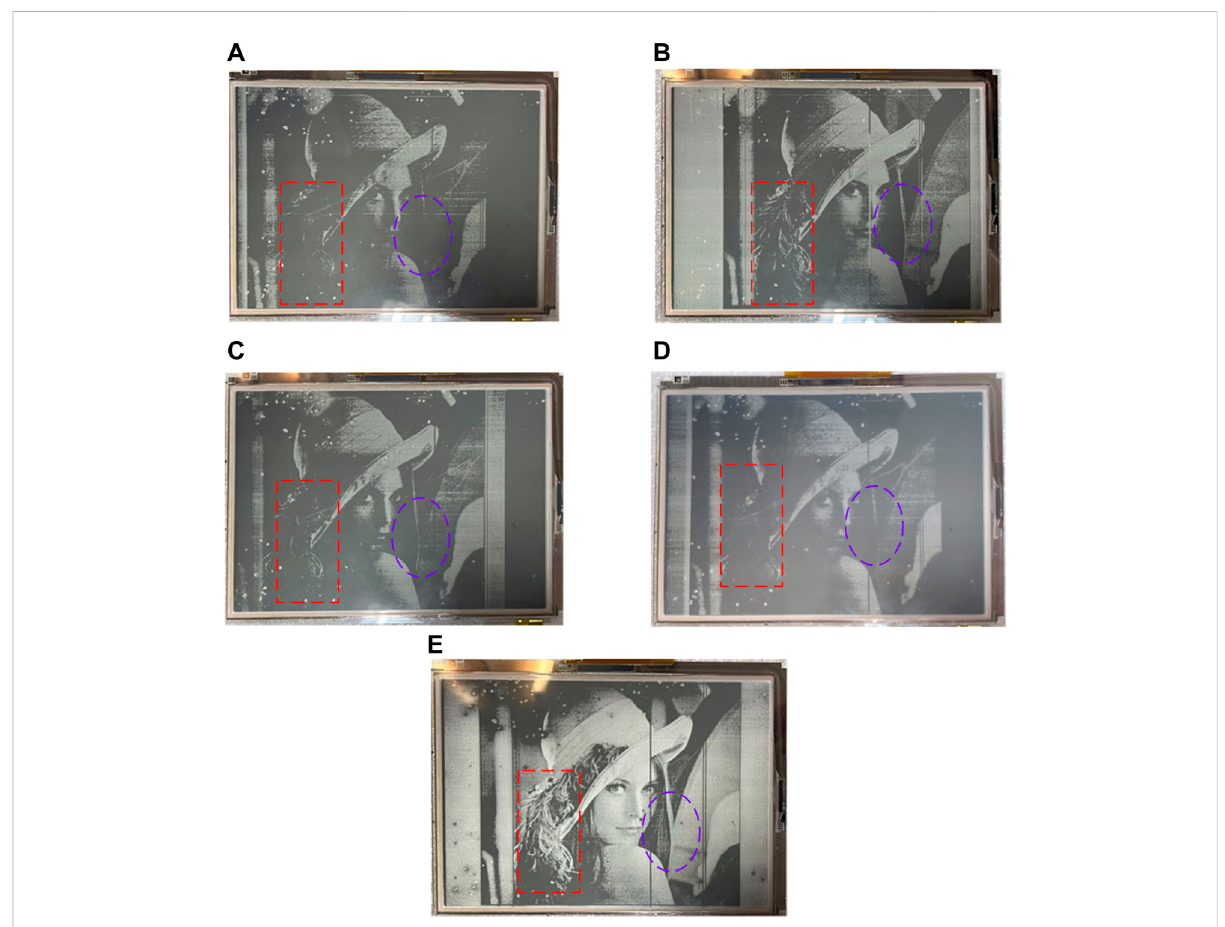
FIGURE 11 The picture of ‘ Lena ’ displayed on the EWD. (A) Displayed with the AC driving composed of +15 V and -15 V. (B) Displayed with the AC driving composed of +20 V and -20 V. (C) Displayed with the AC driving composed of +20 V and -15 V. (D) Displayed with the AC driving composed of +20 V and -20 V. (E) Displayed with the +15 V DC driving